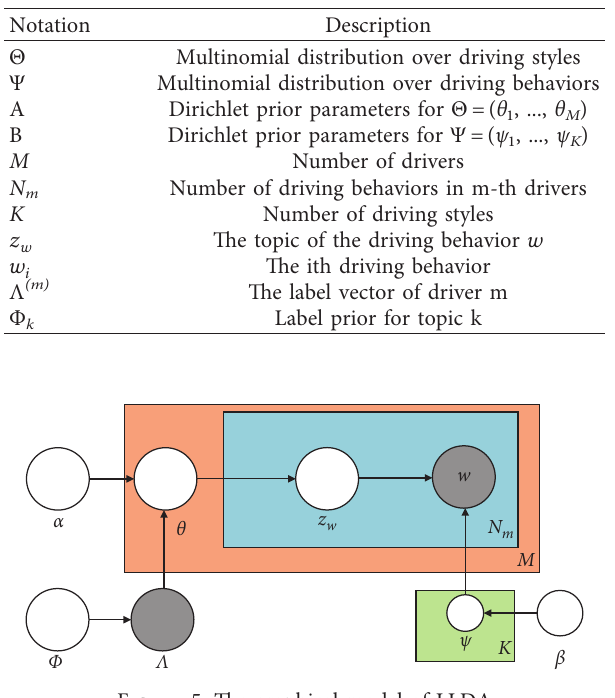
Figure 4: The frequency distributions over driving behavior words on parted driving data. Table 2: Mathematical notation for the labeled LDA model.